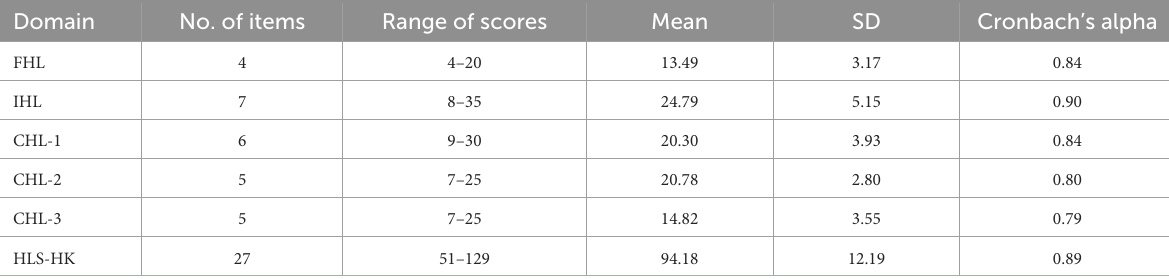
TABLE 4 Internal consistency of the HLS-HK (27items).